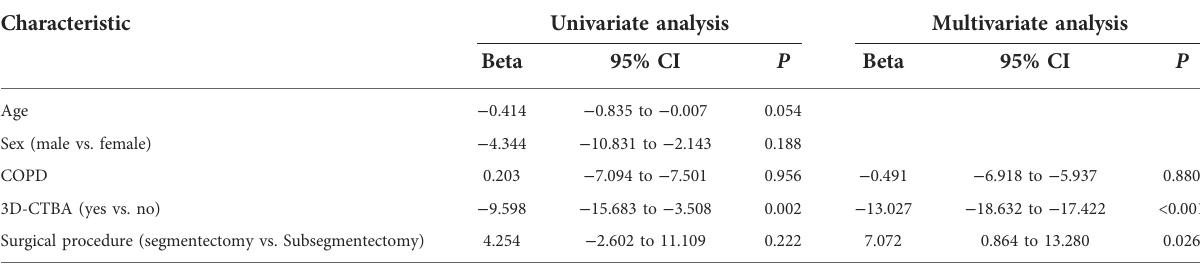
TABLE 4 Univariate/multivariate analyses of factors affecting the operation time for patients who underwent segmentation of the right upper lobe. Characteristic